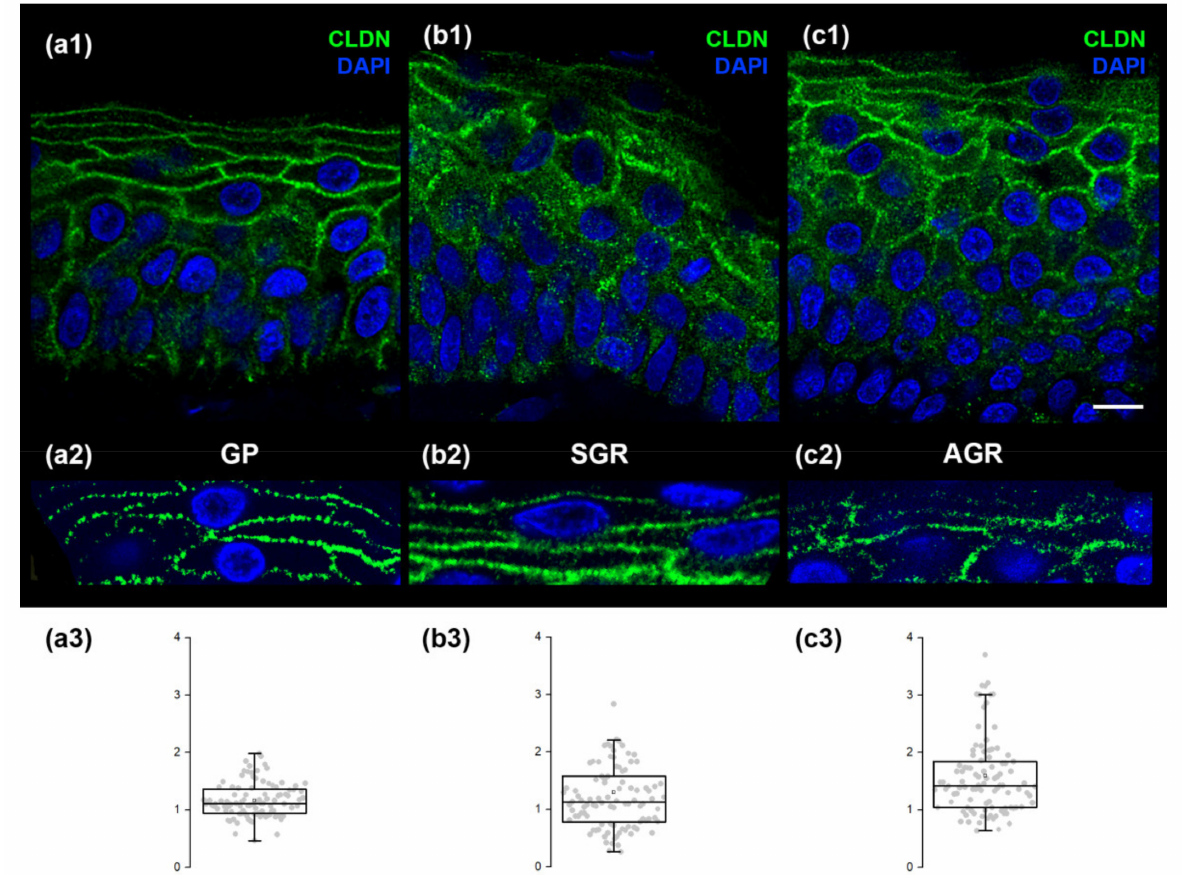
Figure 4. CLDN1, representing tight junctions, exhibits a highly regular pattern in GP regions but is less organized in SGR and AGR areas. Micrographs of single 1 µ m-thick confocal optical sections demonstrate the distribution of CLDN1 through the layers of the epidermis. The strongest expression of CLDN1 was observed in the stratum granulosum of all skin regions ( a1 , b1 , c1 ), while immunostaining widened towards the stratum spinosum of SGR and AGR skin areas ( b1 , c1 ). The distribution of CLDN1 immunostained dots was highly regular in GP skin ( a2 ), but was less regularly organized in SGR ( b2 ) and formed clusters in AGR ( c2 ). Quantification of the differences in regularity is shown as box plots in ( a3 , b3 , c3 ); each dot represents the distance between two adjacent desmosome structures around keratinocytes. Note the narrower dispersion of data points in ( a3 ) compared with ( b3 , c3 ). Scale bar: 10 µ m The Y -axis represents distances in micrometers in ( a3 , b3 , c3